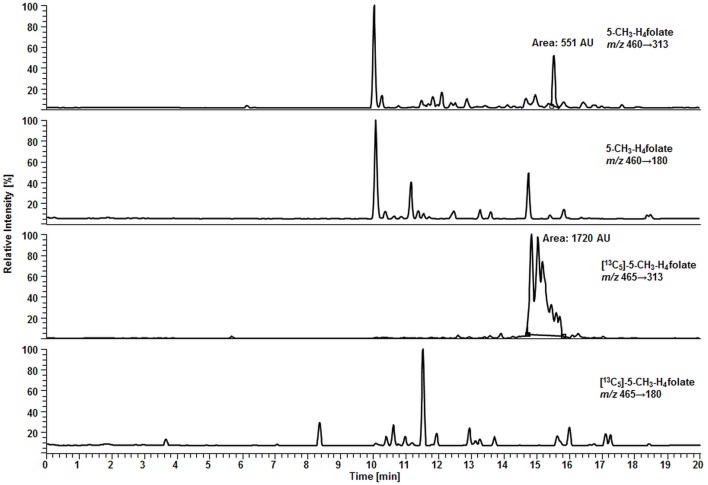
Liquid chromatography–tandem mass spectrometry chromatogram of a water blank.